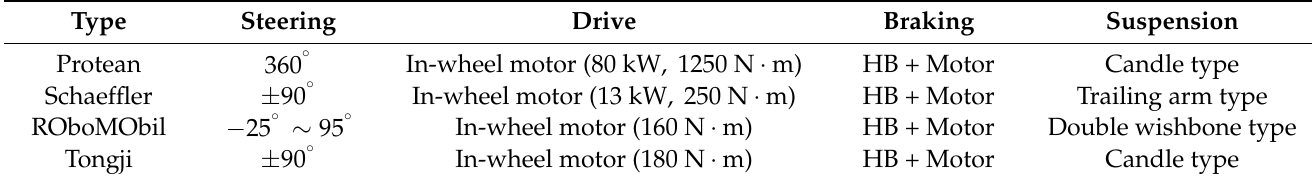
Table 2. Structure analysis of integrated X-by-wire modules for 4WID-4WIS EV.